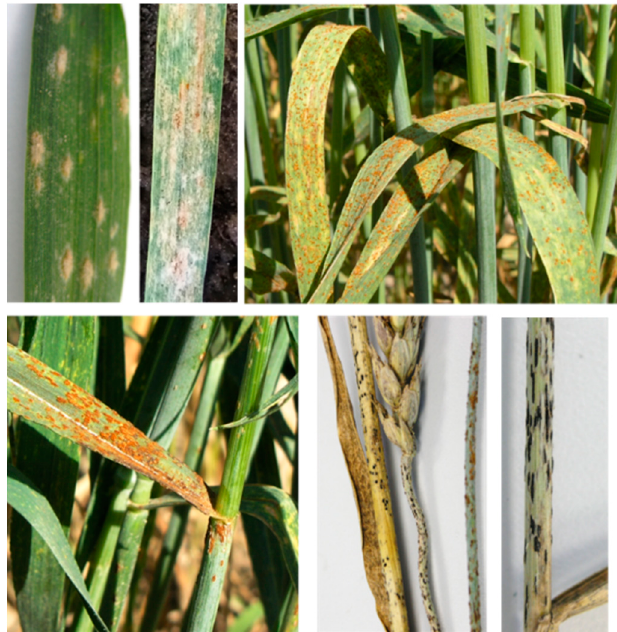
Figure A2. The traits of the fungal pathogens diseases affected wheat. Powdery mildew caused by Erysiphe (Blumeria) graminis ( left picture in the top panel ); leaf rust caused by Puccinia triticina ( right picture in the top panel ); and stem rust caused by Puccinia graminis ( in the bottom row ).